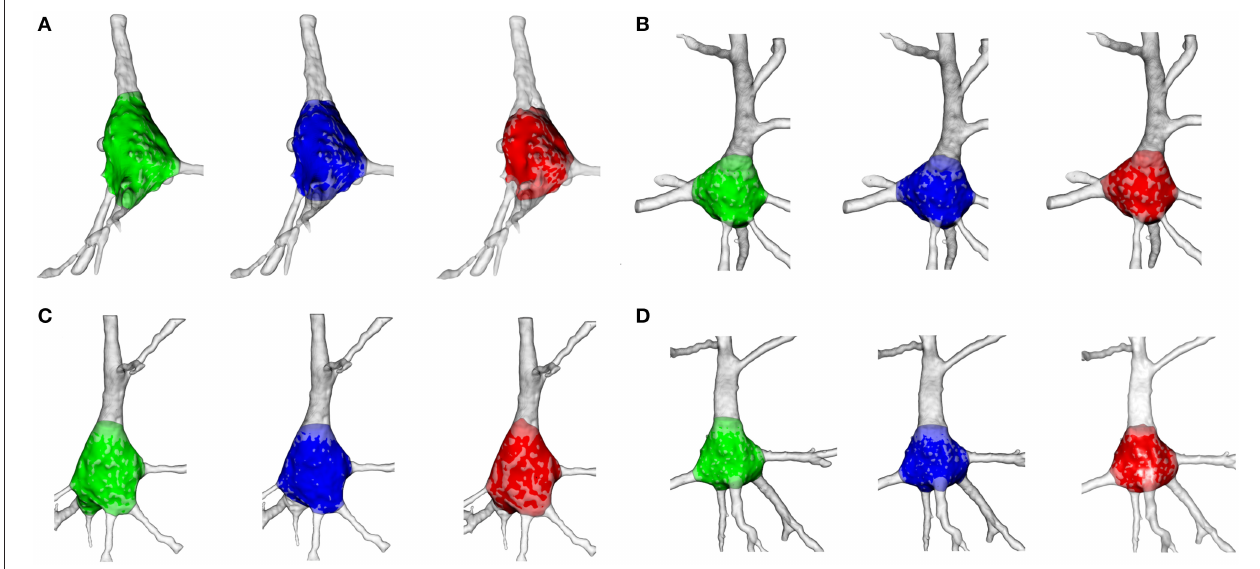
FIGURE 9 | Illustration of the goodness of the soma segmentation method on four cells. The somata segmented manually by the first neuroanatomist are shaded green, the somata segmented by the second neuroanatomist are shaded blue and the somata segmented according to the proposed procedure are shaded